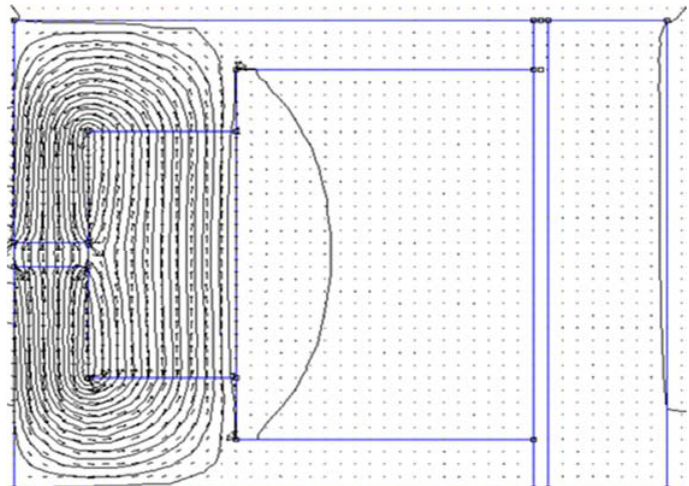
Fig. 6. The NC MR valve magnetic field